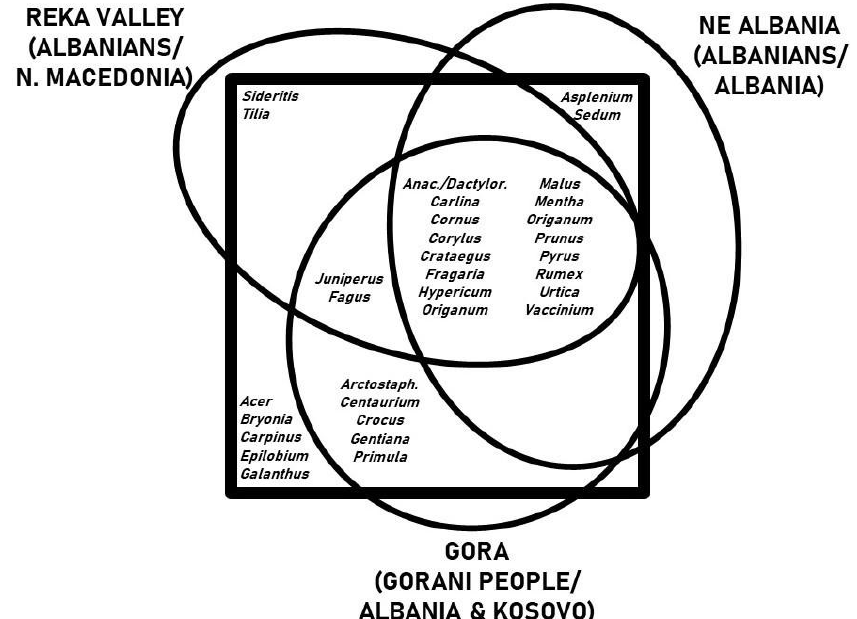
Figure 5. Venn diagram showing the overlap of the wild food and herbal plant genera documented in the present study (within the bold square) with those recorded in surrounding areas, both among Albanians and the Slavic Gorani people (see Figure 6).